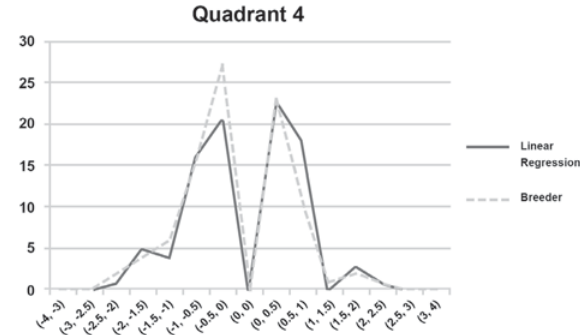
Figure 2- Predictions on the validation set